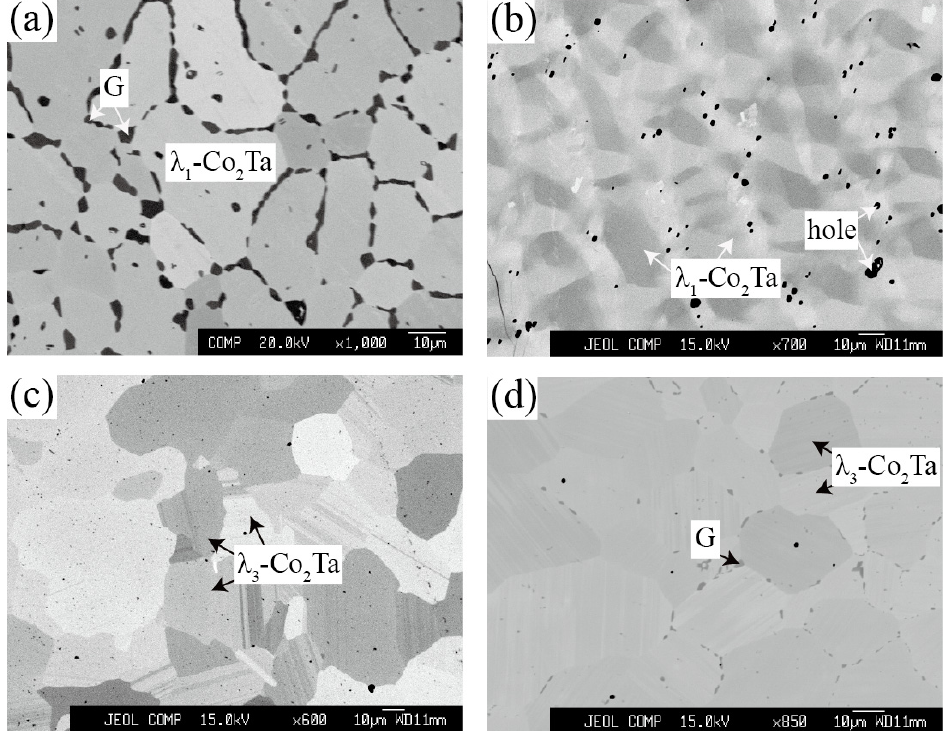
Figure 8. Typical ternary micrograph images obtained of ( a ) Co 54 Ta 28 Si 18 alloy annealed at 1100 °C for 60 days; ( b ) Co 59 Ta 31 Si 10 alloy annealed at 1100 °C for 60 days; ( c ) Co 65 Ta 27 Si 8 alloy annealed at 1100 °C for 60 days and ( d ) Co 65 Ta 27 Si 8 alloy annealed at 900 °C for 90 days.